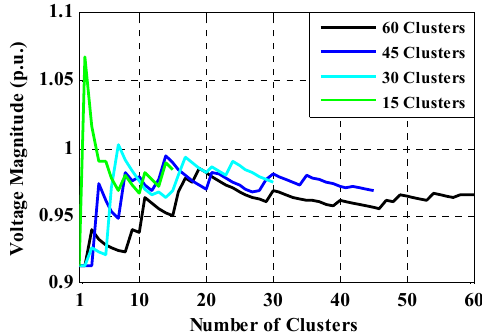
Figure 8. Convergence process of bus-33 for clustering-based MCS.